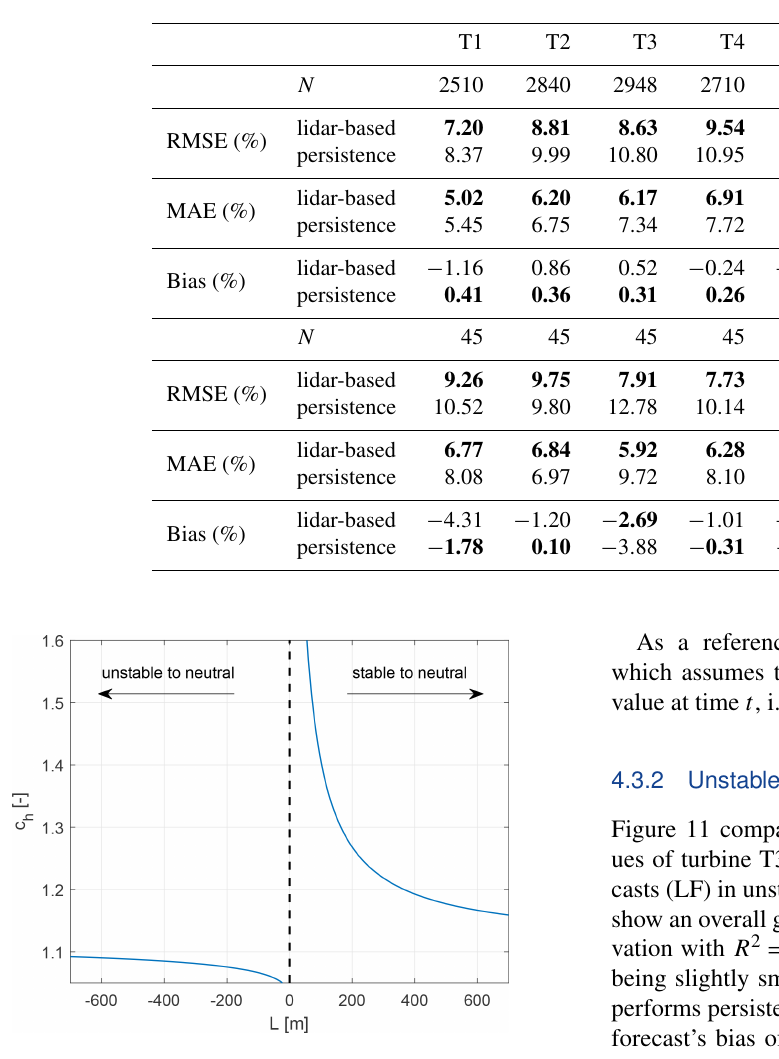
Figure 10. Dependence of the height extrapolation factor c h on the Obukhov length L . In this example an extrapolation from 24.6 to 92m with a roughness length of z 0 = 0 . 0002m is